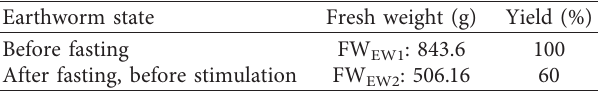
EW1,2 ) and yields before